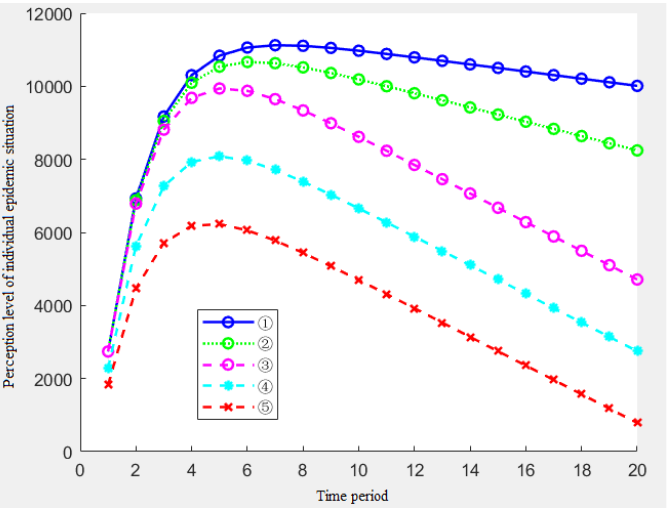
Figure 8. Changes of the epidemic perception when the amount of the information stimulus showed a decreasing